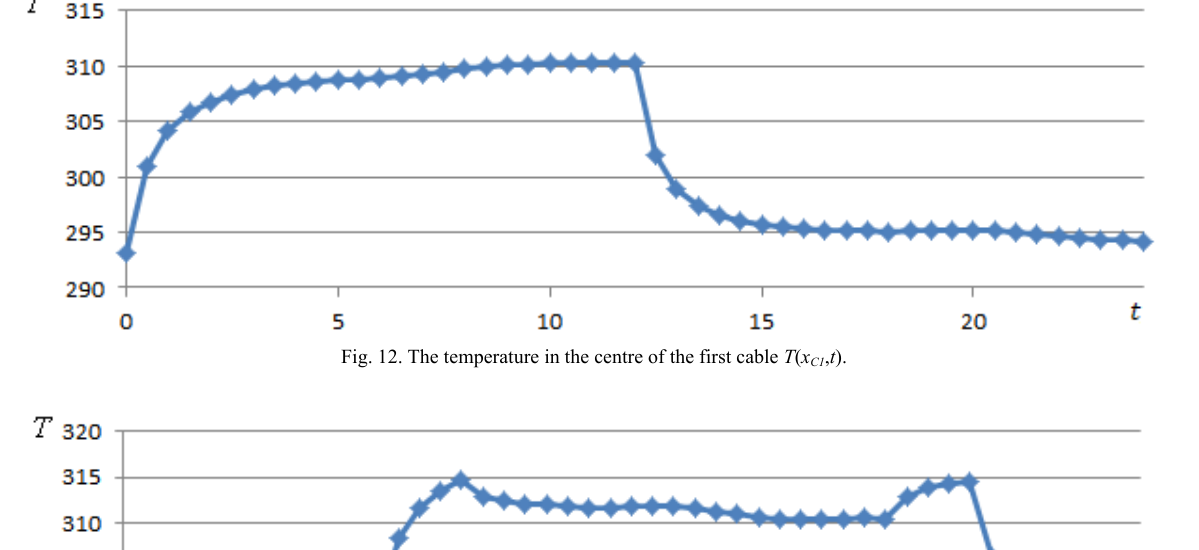
Fig. 12. The temperature in the centre of the first cable T ( x C1 , t ).